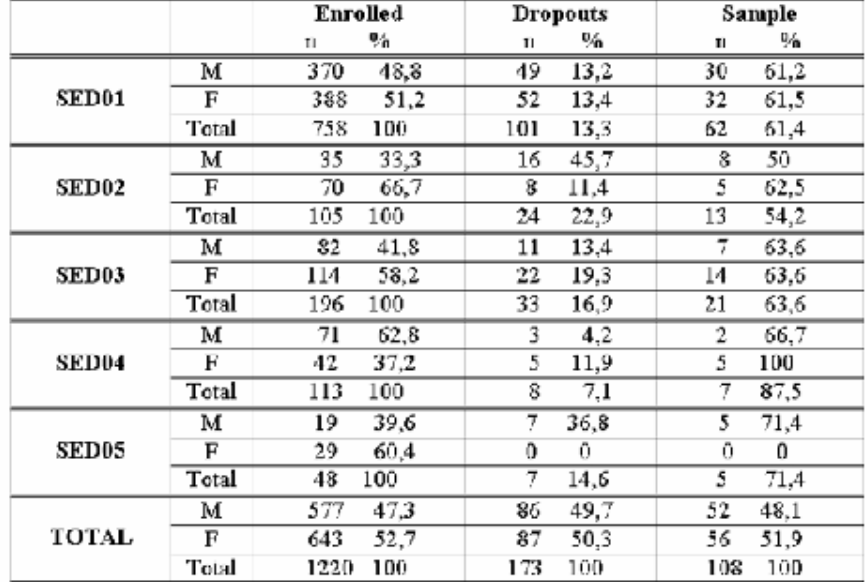
Table 1. Dropout rates of students enrolled in the graduate gourse "Studies in Education" ( m = male, f =